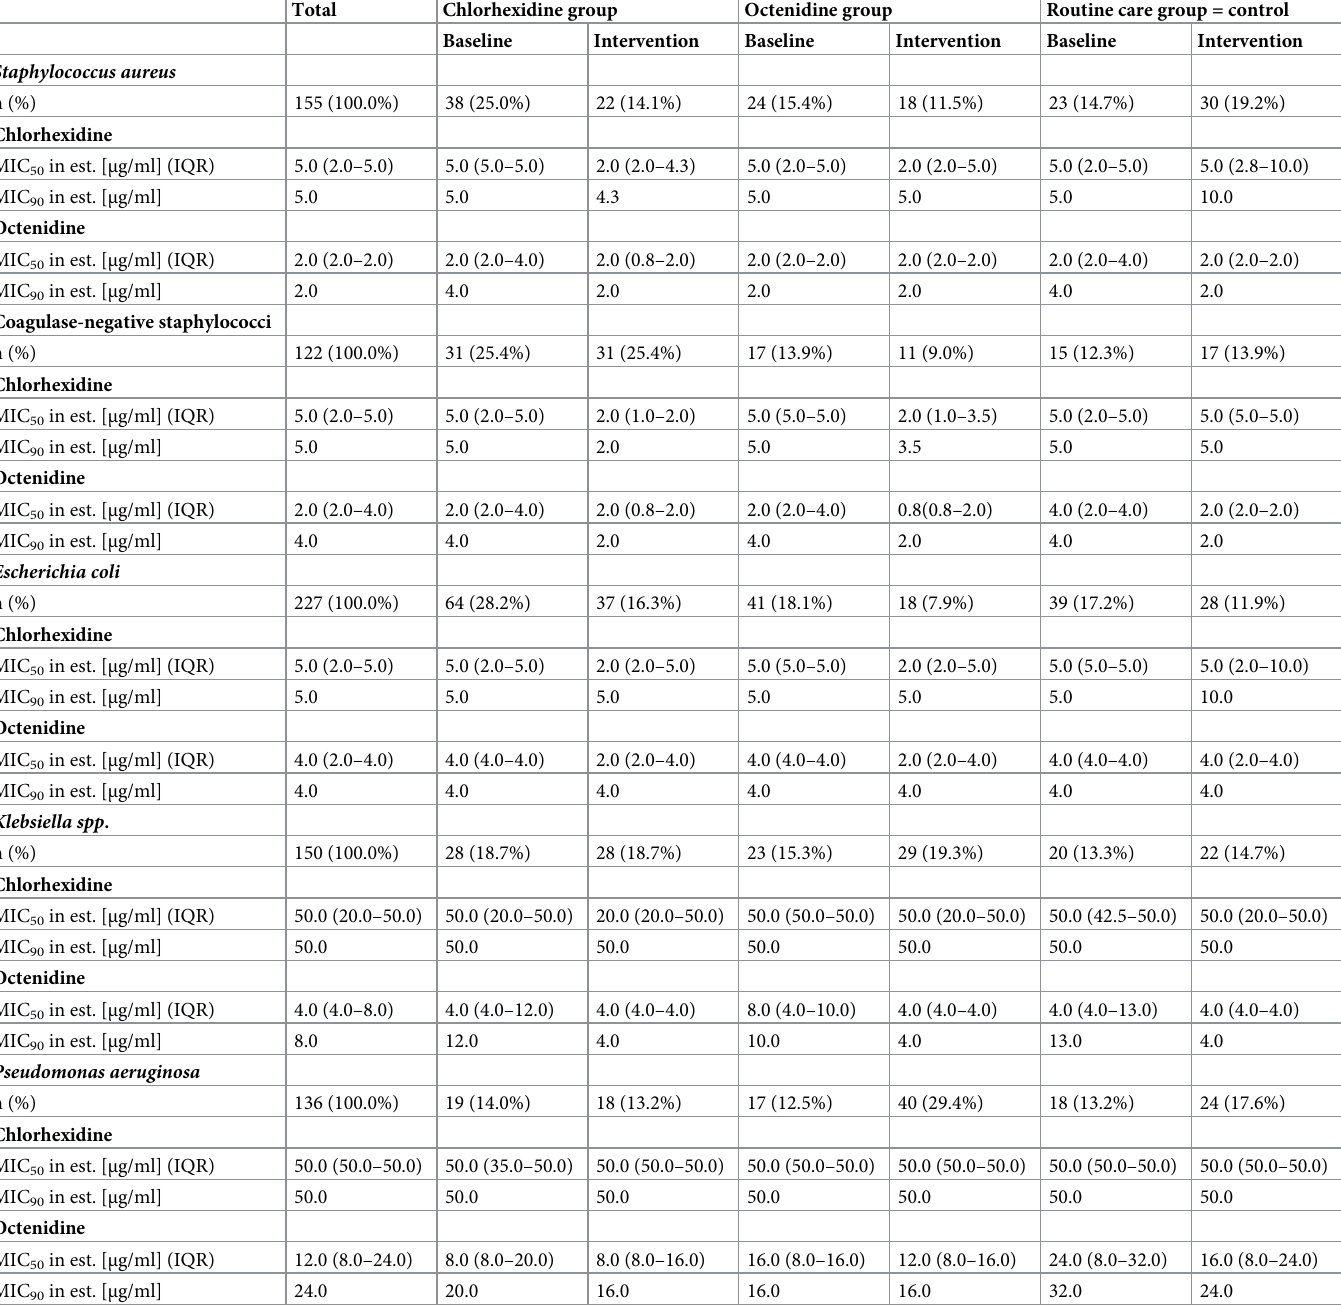
Table 2. Chlorhexidine and octenidine minimal inhibitory concentrations (MIC) of ICU-attributable bacterial isolates from clinical samples reported by study group and period. Total Chlorhexidine group Octenidine group Routine care group = control Baseline Intervention Baseline Intervention Baseline Intervention Staphylococcus